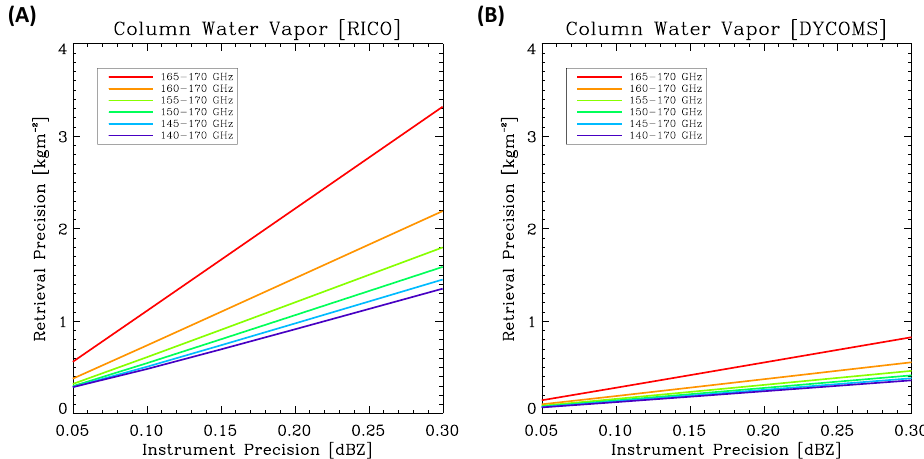
Figure 10. Estimated vapor density retrieval precision as a function of instrument measurement precision for RICO (a) and DYCOMS-II RF01 (b) . The solid, dashed, and, dotted lines correspond to different vertical resolutions for the retrieval, which may be lower than that of the reflectivity observations.